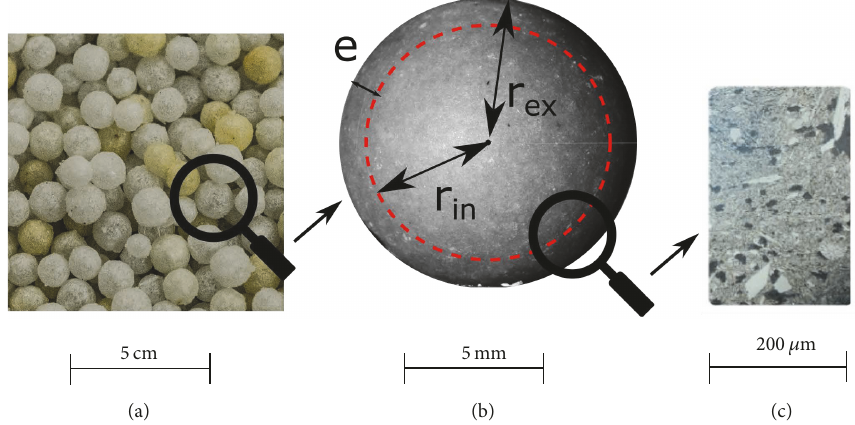
Figure 1: Hollow sphere structure (a), hollow sphere’s parameters (b), and an optical microscope capture of the constitutive material